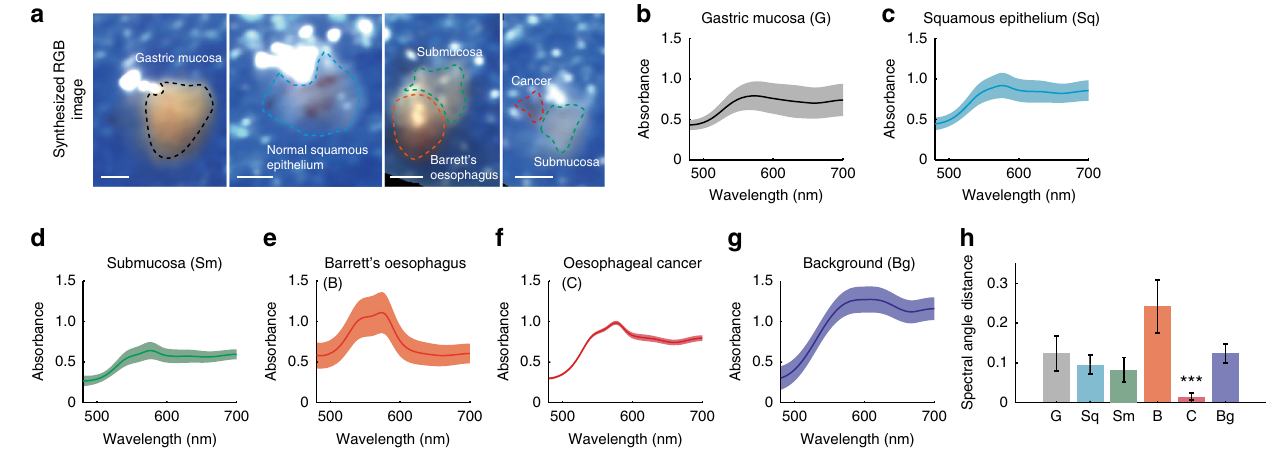
Fig. 7 Hyperspectral imaging (HSI) of ex vivo human tissue from patients shows distinct spectral pro fi les. a Four representative synthesised RGB images of each sample. Dashed line indicates boundary of gastric mucosa, epithelium, submucosa, Barrett ’ s oesophagus and cancer, respectively. b – g Spectra of the identi fi ed tissue types shown in a . Solid lines and shaded areas in b – g indicate mean value and standard deviation of the absorbance pro fi le, respectively. h Spectral angle mapper analysis using average spectral pro fi le of oesophageal cancer as a reference signal. Error bars represent standard deviation. *** indicates p -value < 0.001. Statistical analysis was performed using a one-way ANOVA with post-hoc tests. All tissue was measured using the external illumination method. Scale bars = 1